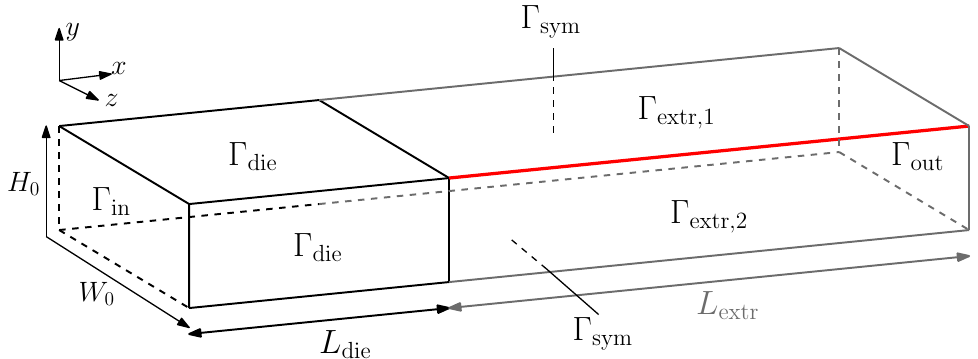
Figure 2. Schematic representation of the 3D problem of an extrudate emerging from a rectangular die. The corner line used in the corner-line method is depicted in